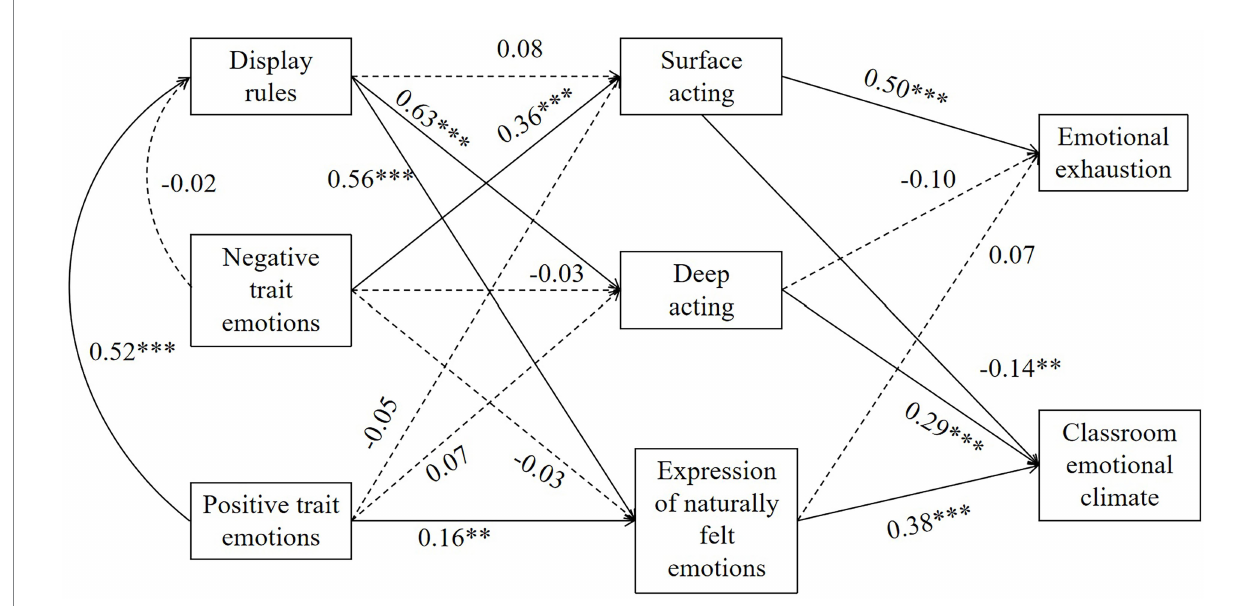
FIGURE 3 Schematic diagram of structural equation model results. ** p < 0.01, *** p < 0.001.